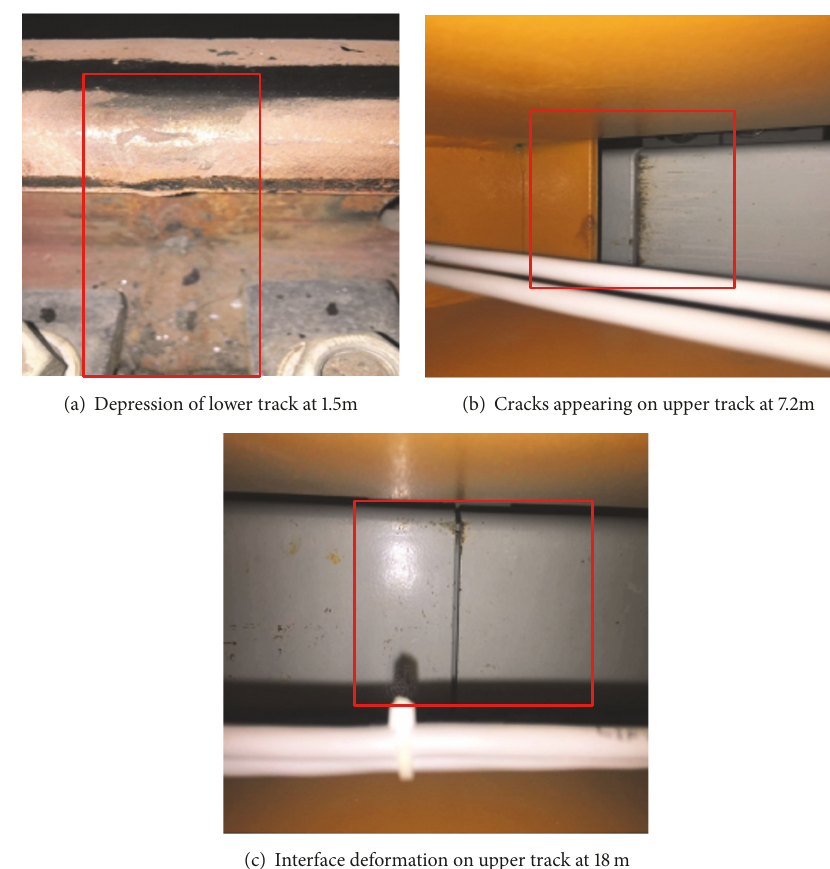
Figure 11: Testing and detecting sample photos from